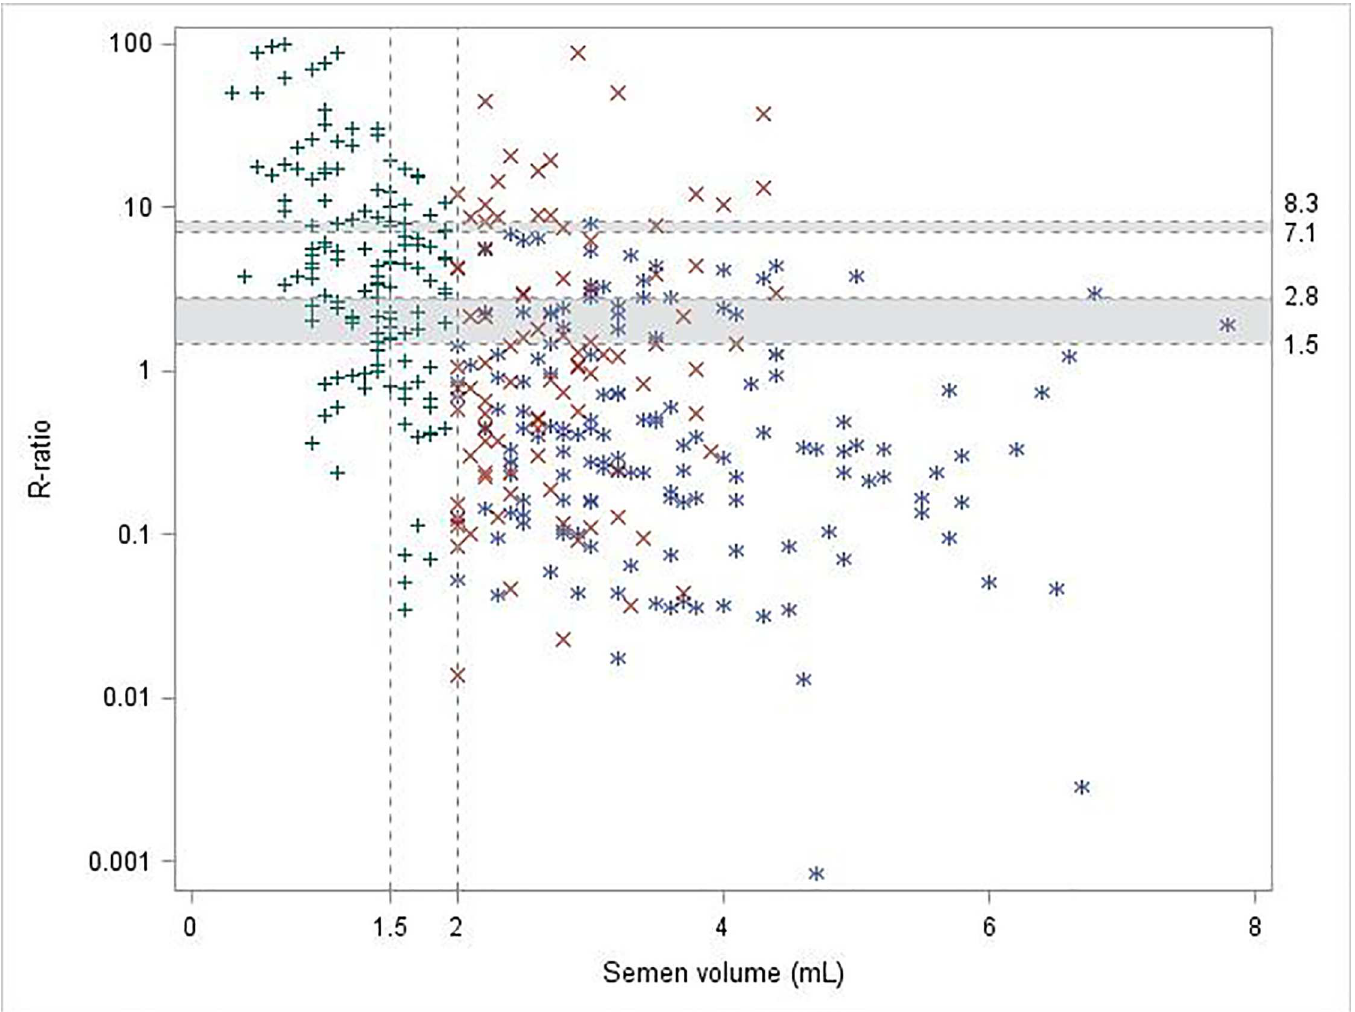
Fig 3. Distribution of patients according to R-values and semen volume. Referencelines were drawn on x-axis to represent WHO lower reference limits for semen volume (1.5 mL [20] and 2 mL [16]) and on y-axis to represent low and high R-value thresholds obtainedfrom CART procedure (1.5% and 2.8%, 7.1% and 8.3% respectively). + (green), 146 patients with observedlow semen volume ( < 2 mL) × (red), 99 patients with normalizedsemen volume ( (cid:21) 2 mL) * (blue), 162 patients with normalsemen volume ( (cid:21) 2